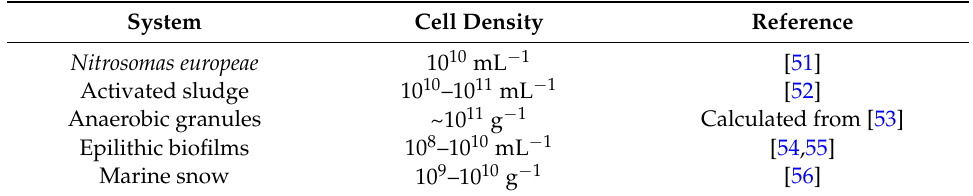
Table 3. Cell numbers in